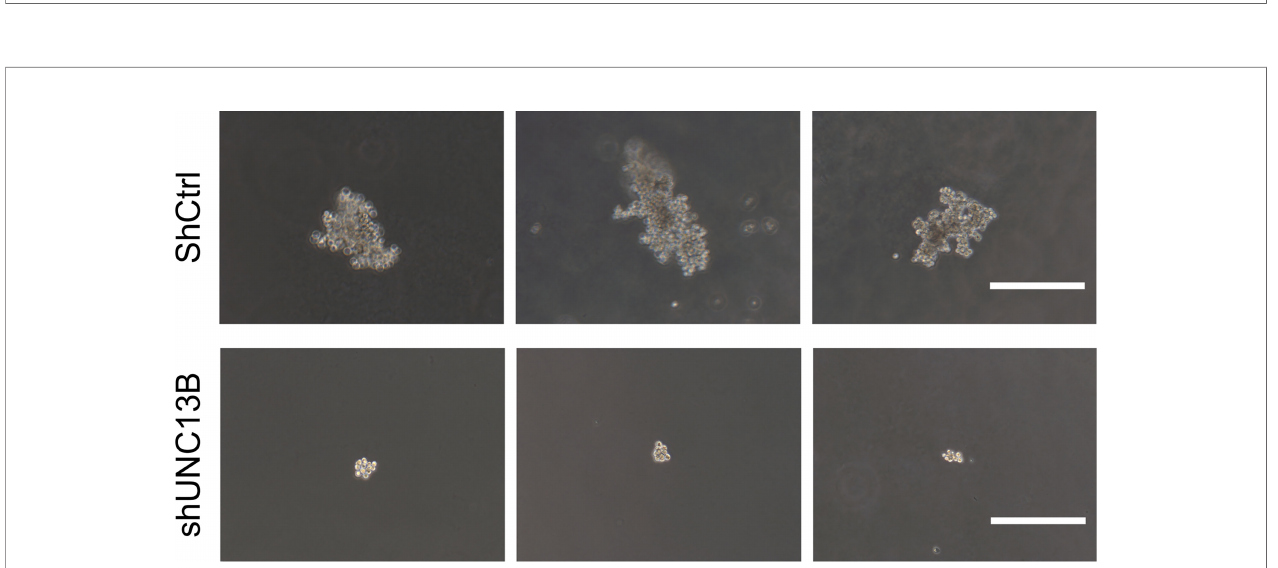
FIGURE 3 | Soft agarose colony formation of arsenic trioxide (ATO)-resistant K-562 cells after UNC13B knockdown. Three representative images of each group. Scale bar: 500 µm.